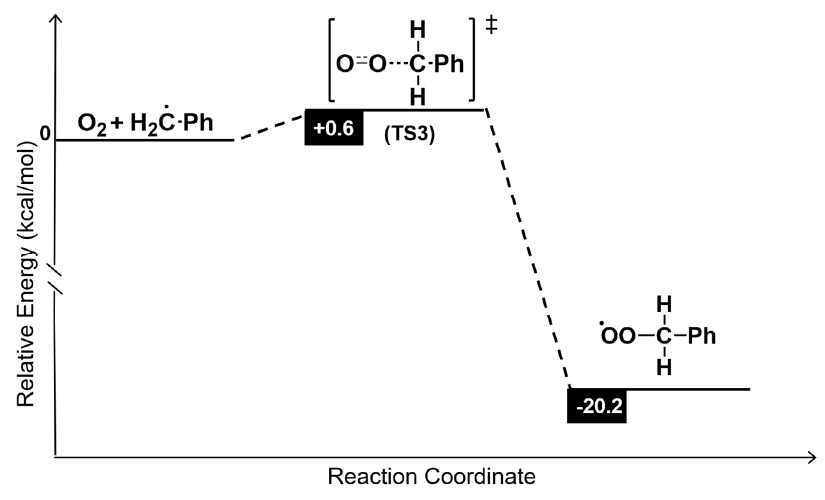
Figure 6. Relative energy diagram vs. reaction coordinate for TS3.